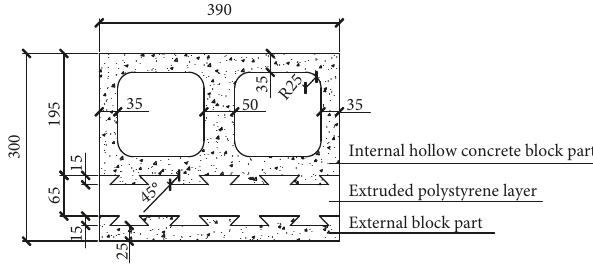
Figure 1: The tenon composite block (mm).